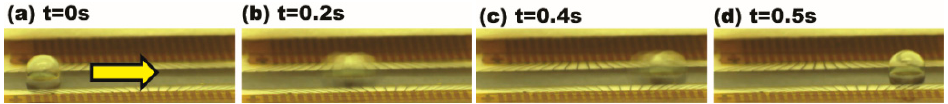
Figure 3. Video snapshots showing the transportation of a 30 µL water droplet on a single-sided surface without complex mechanical components. A transportation speed was as fast as 7.5 cm/s at a given voltage of 35 V. ( a ) t = 0 s; ( b ) t = 0.2 s; ( c ) t = 0.4 s; ( d ) t = 0.5 s.